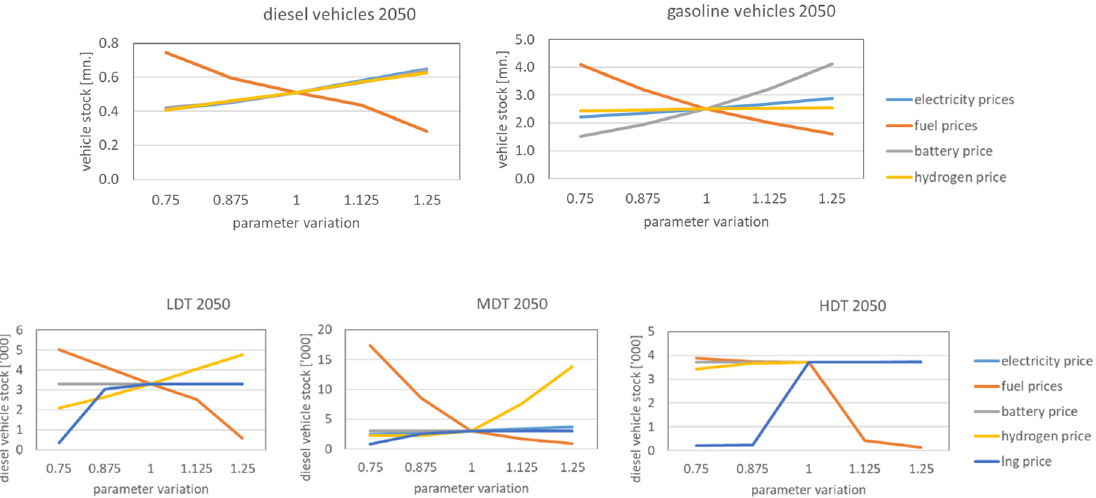
Figure 5. Sensitivities on conventional vehicle stock in 2050 in the electricity-focused scenario for changes in energy prices. Variation of energy prices by − 25% to +25% shown on the x-axis and respective results for diesel or gasoline passenger cars (upper panel) and diesel vehicles in LDT, MDT, and HDT (lower panel). Changes for electricity price (blue), fuel (gasoline + diesel) prices (orange), battery price (gray), hydrogen price (yellow), and LNG price for trucks (dark blue).